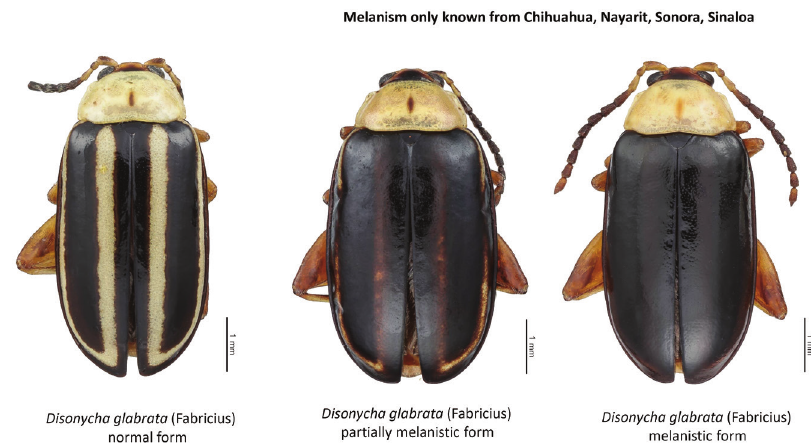
Figure 13. Disonycha glabrata (Fabricius) species color forms.